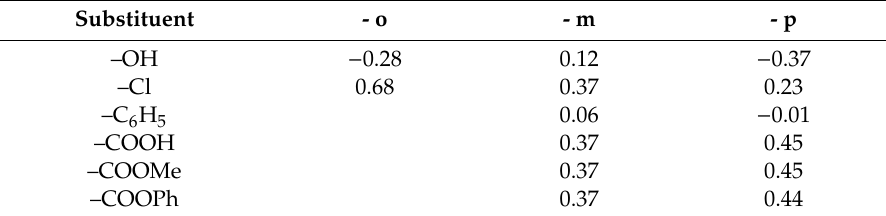
Table 3. Substituent constant ( σ i ) for various positions in the aromatic ring [31,32].